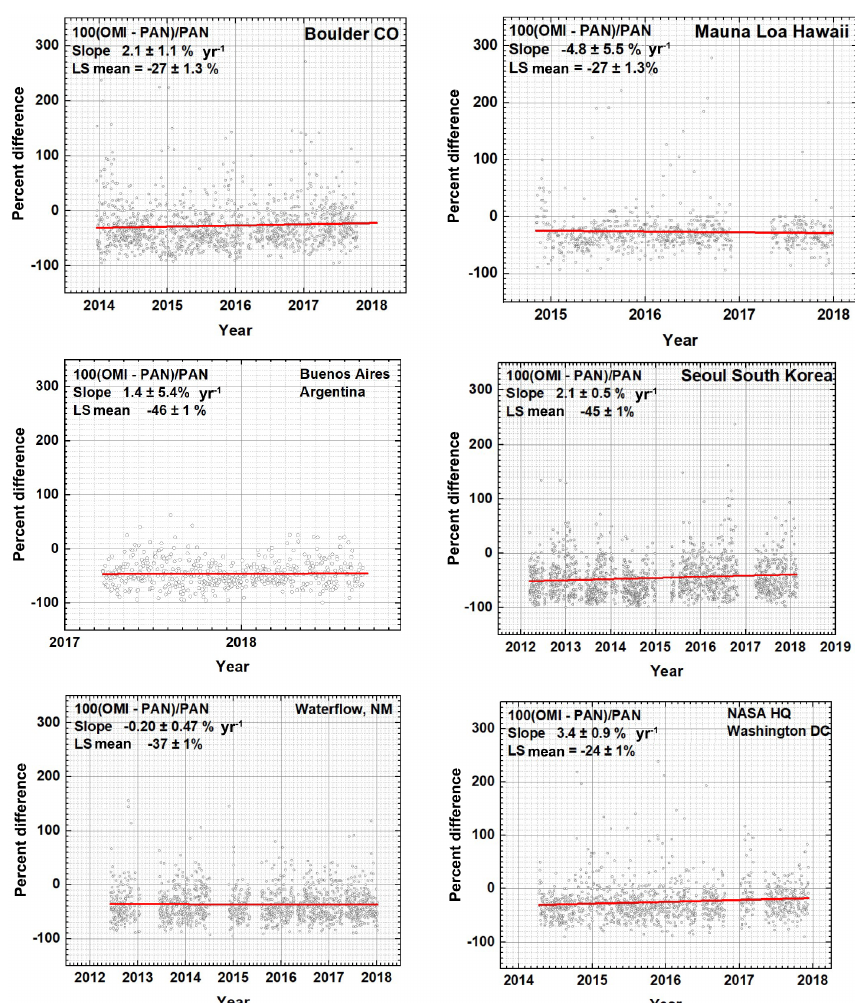
Figure 7. Percent differences between OMI and PANDORA. The slopes are the absolute change in the percent difference. For example, the Boulder percent difference goes from − 31% to − 23% over 4 years. The LS means are least squares means with the corresponding error estimates.